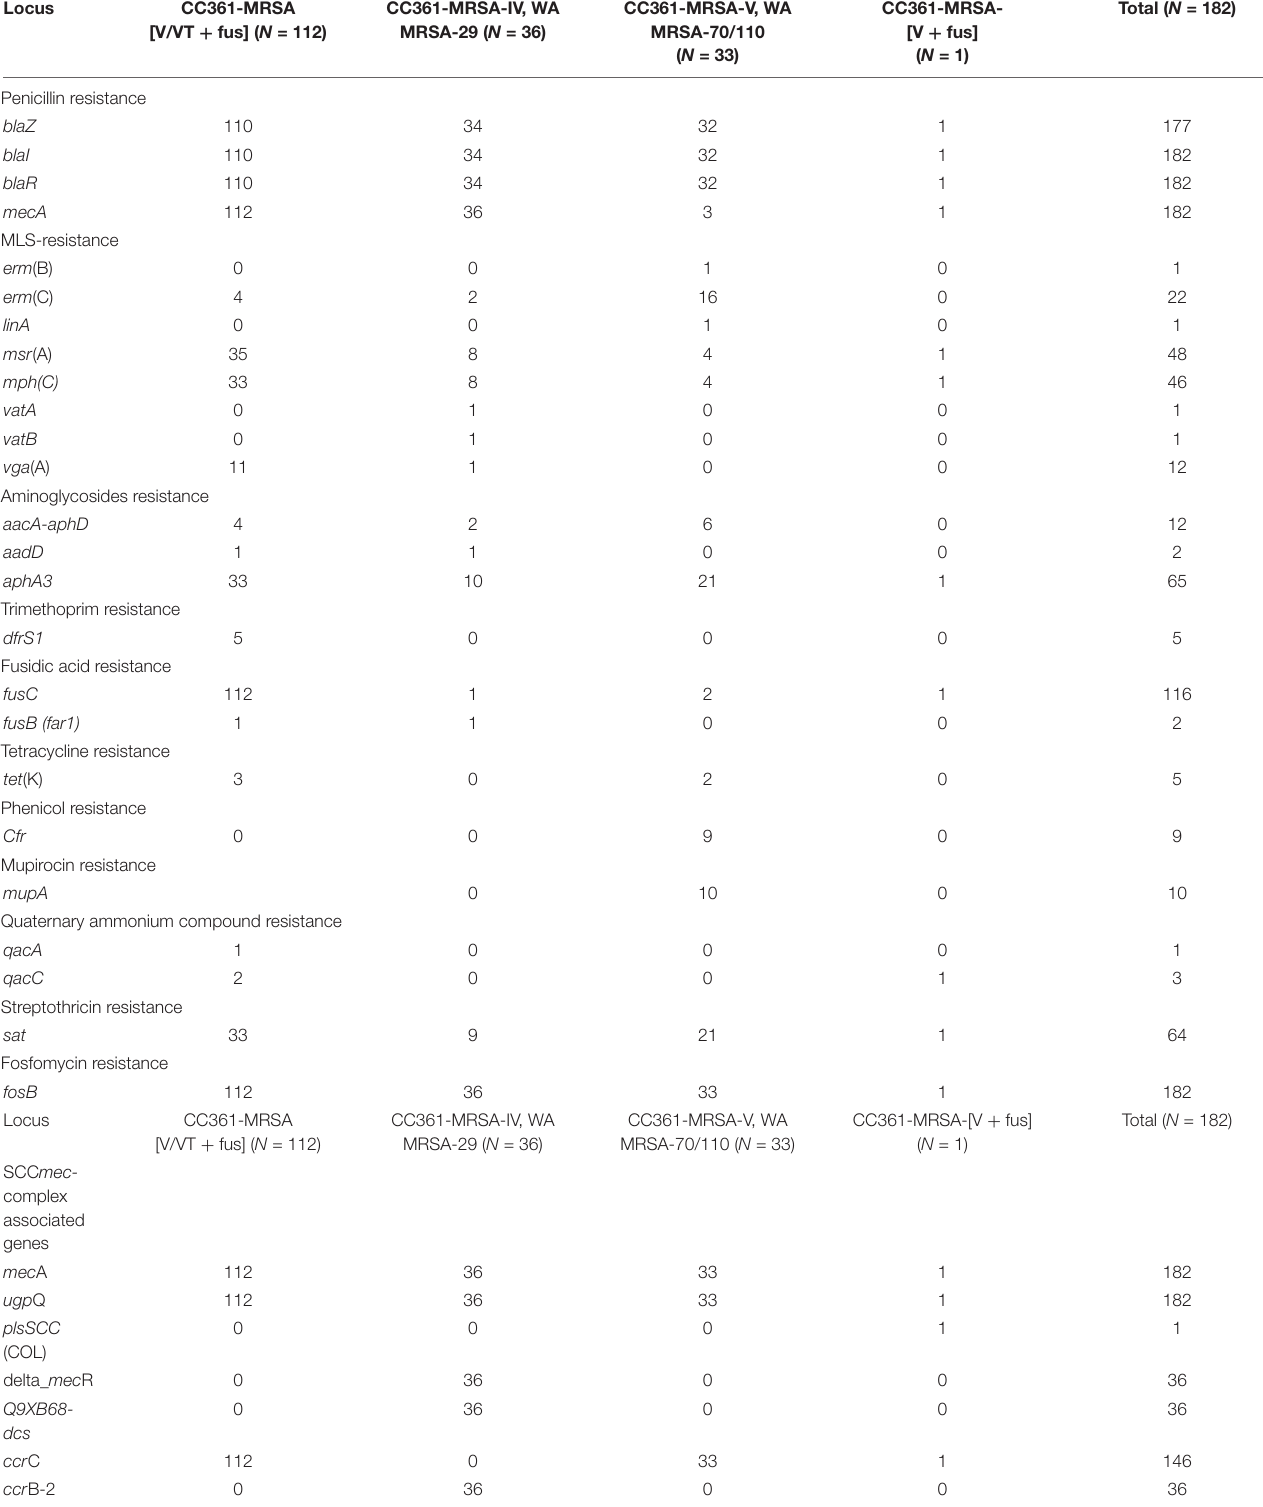
TABLE 2 | Distribution of antibiotic resistance genes of CC361-MRSA isolates from 2016 to 2018.